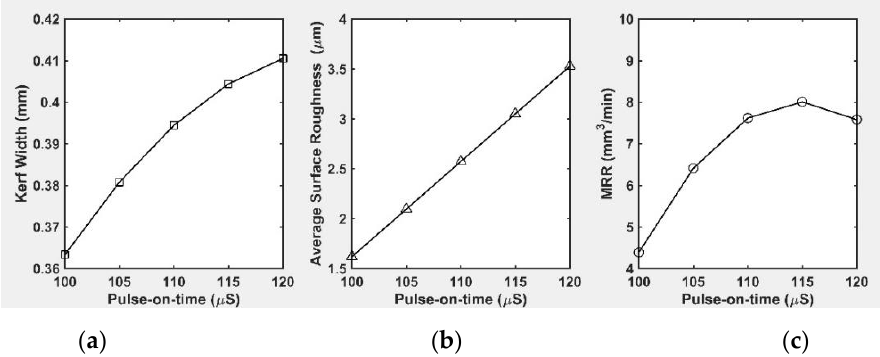
Figure 4. Effects of pulse-on-time (T ON ) on ( a ) kerf width, ( b ) surface roughness and ( c ) MRR.